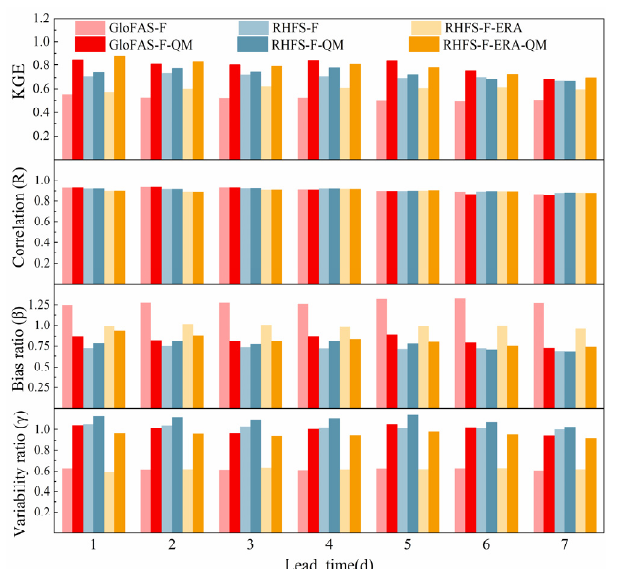
Figure 10. KGE, correlation (R), bias ratio ( β ) and variability ratio ( γ ) of the discharge reforecast ensemble mean at lead times of 1–7 d during the verification period (2007, 2008, June–October). KGE = modified Kling–Gupta efficiency coefficient.